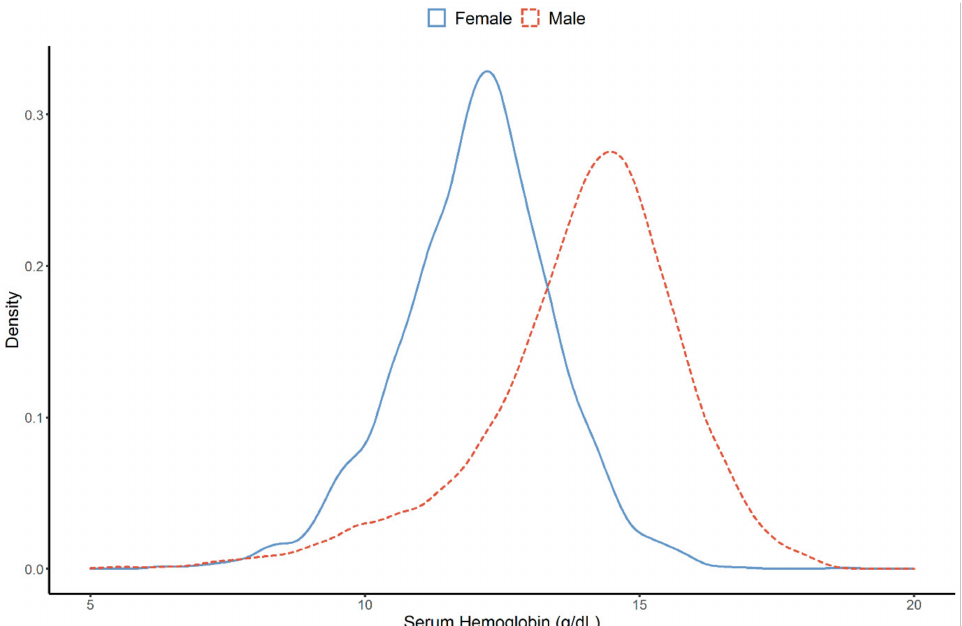
Figure 2. Difference in distribution of serum hemoglobin by